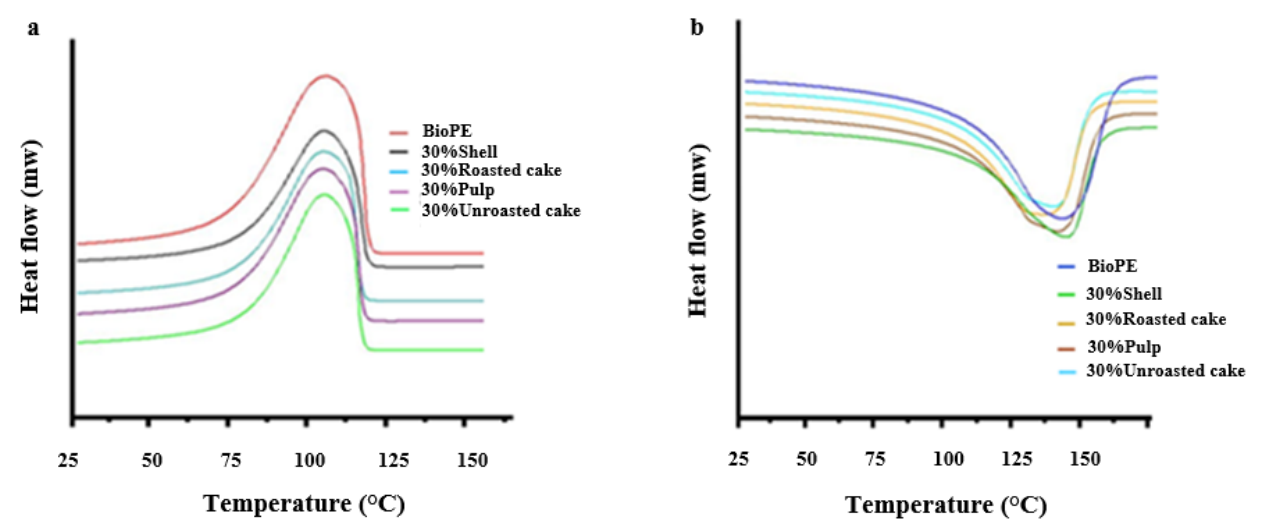
Figure 5. Differential scanning calorimetry: ( a ) second heating thermogram, ( b ) second cooling thermogram. Table 3. Thermal parameters determined using differential scanning calorimetry (DSC).